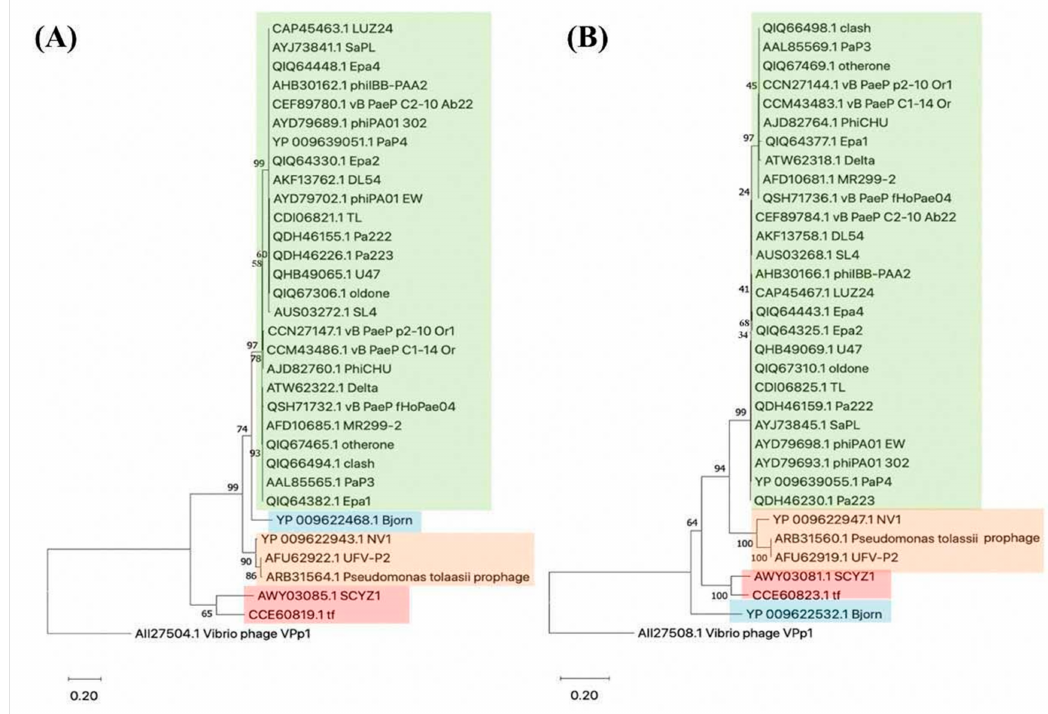
Figure 1. Phylogenetic relationships of phage Delta with other related phages (members of Bruynoghevirus —green, Krylovvirus —red, Vicosavirus —orange and Bjornvirus —blue) and a prophage of P. tolassii , based on amino-acid sequences of major coat protein ( A ) and terminase ( B ). The evolutionary history based on protein sequences was inferred using the Maximum Likelihood method and JTT matrix-based model. Initial trees for the heuristic search were obtained automatically by applying Neighbor-Joining and BioNJ algorithms to a matrix of pairwise distances estimated using a JTT model, and then selecting the topology with superior log likelihood value. Evolutionary analyses were conducted in MEGA X [18] and the percentage of replicate trees in which the associated taxa clustered together in the bootstrap test (1000 replicates) are shown next to the branches [19]. Vibrio phage VPp1 was used as an